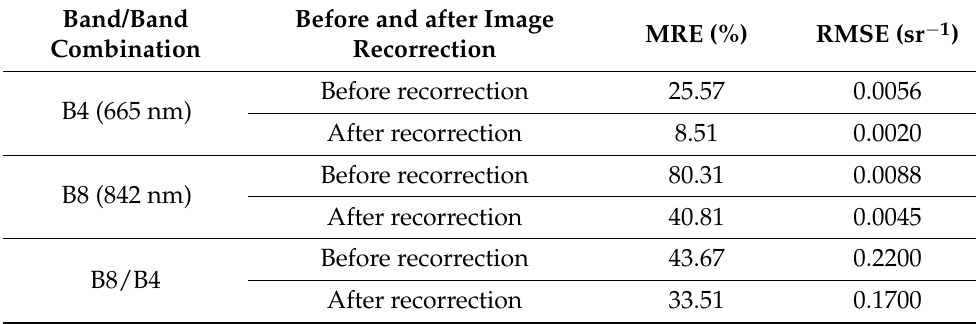
Table 2. Comparison of Sentinel-2 data errors before and after recorrection.